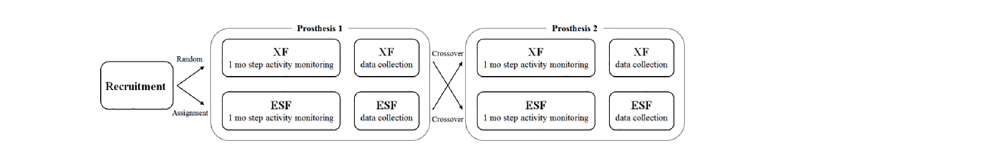
Fig 3. Overview of the randomized crossover study